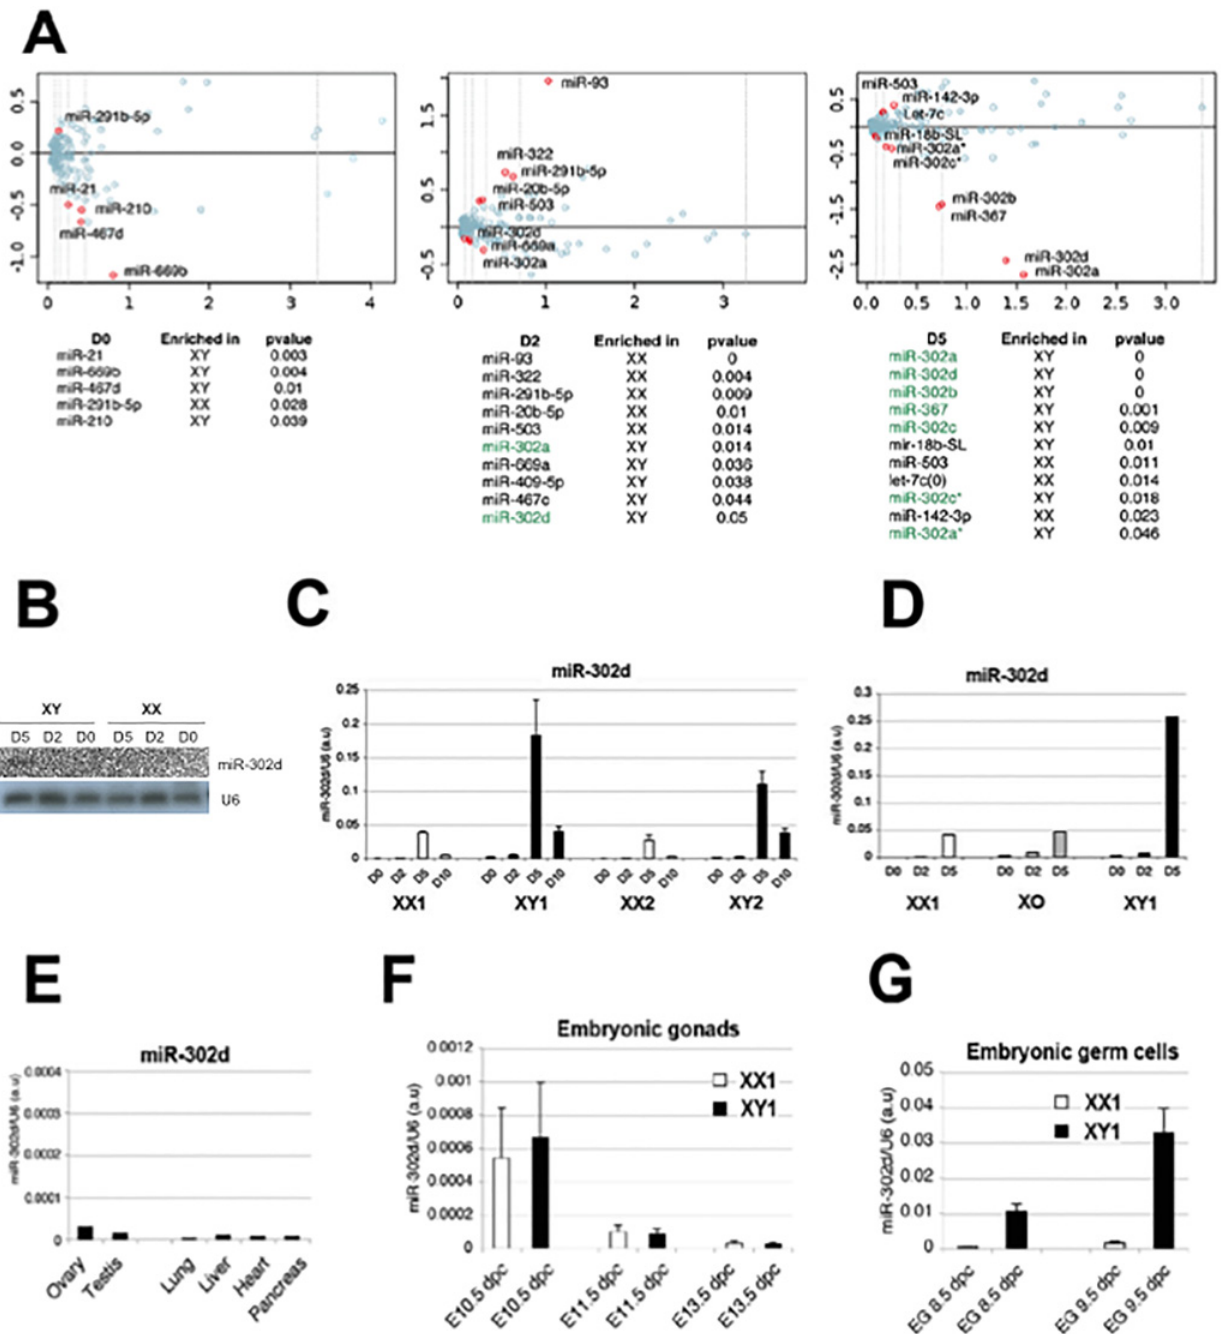
Fig 3. Male-specific regulation of the miR-302 gene in embryonic stem cells and germ cells. (A) MA Plot of microRNAs singularizes those enriched in male (E14, XY1) or female (PGK, XX1) cells at different time points, as indicated in red (see Materials and Methods for details). (B) Northern Blot analysis of miR-302d in female (XX1; PGK) and male (XY1; E14) cell lines at D0, D2, and D5 of differentiation. (C,D) Quantification by QRT-PCR analysis of mature miR-302d in two independent female (PGK, XX1 and LF2, XX2) and male (E14, XY1 and HM1, XY2) ES cell lines at D0, D2, D5, and D10 of differentiation (C) and in the XPGKO ES cell line (D). (E) Quantification by RT-PCR of miR-302d accumulation in various adult mouse tissues. (F,G) Quantification by RT-PCR of mir-302d expression in male (XY, black) and female (XX, white) gonads at 10.5 to 13.5 dpc (F) and 8.5 to 9.5 dpc. (G) Same as in (F), but in male (XY, black) and female (XX, white) embryonic germ cells